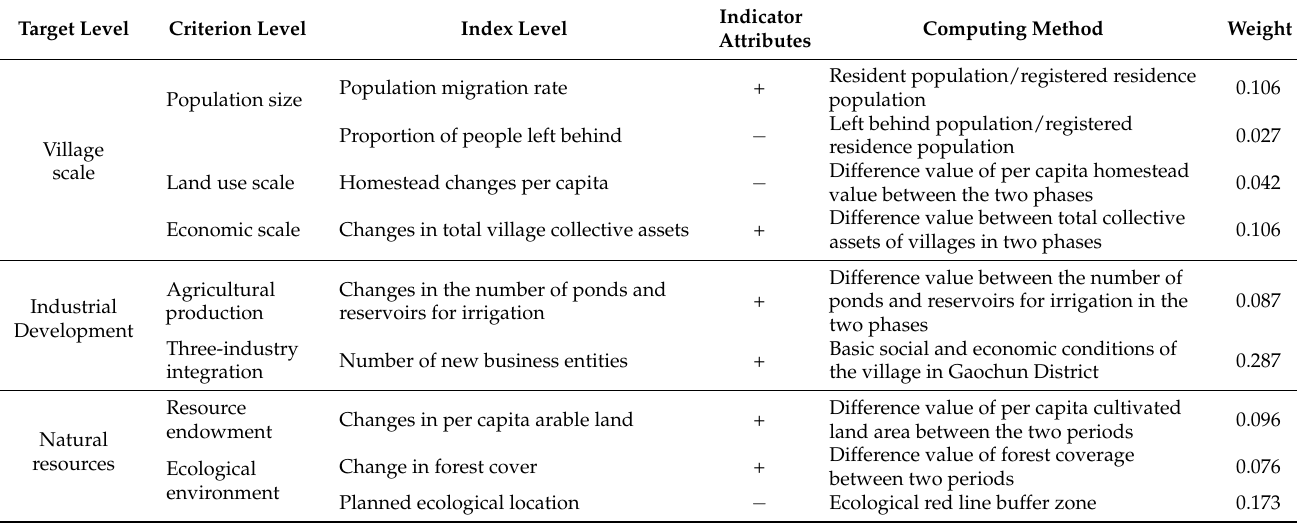
Table 2. Weight of village reconstruction